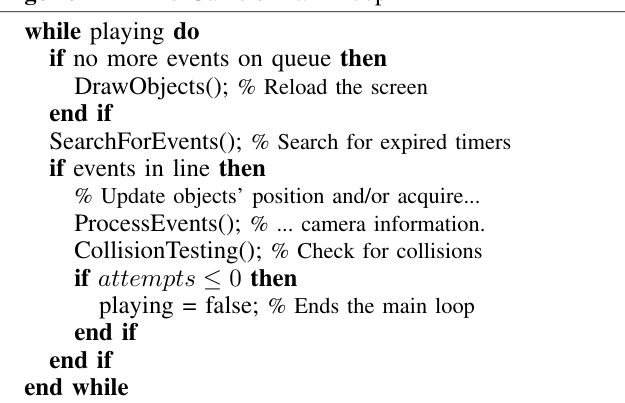
The Algorithm 1 provides an overview of the main game loop, highlighting the major activities. Algorithm 1 The Game’s Main